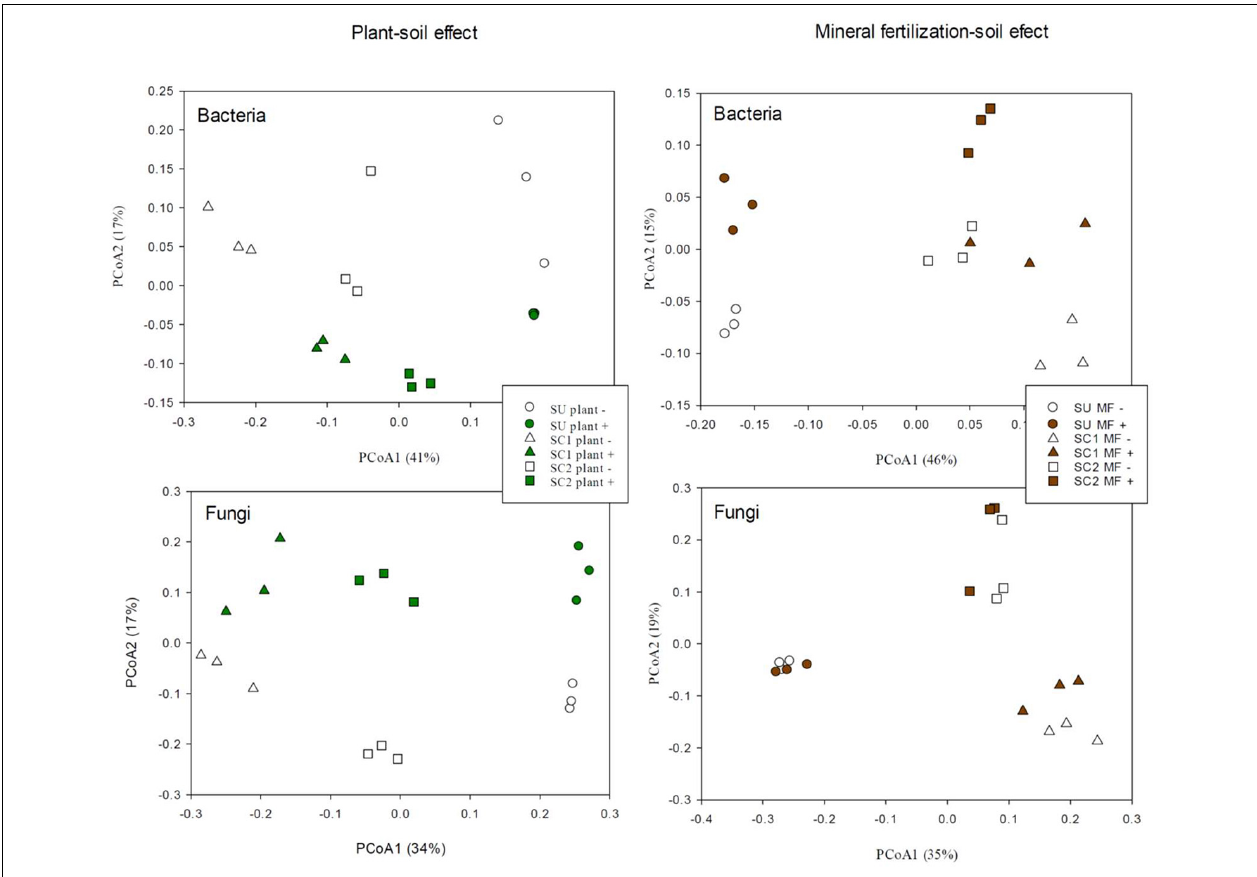
FIGURE 2 | Principal coordinate analysis (PCoA) of bacterial and fungal operational taxonomic units (OTUs) in the three different used soils (S, SC1, SC2) combined with the effects of the presence of plant and the effects of used soils (S, SC1, SC2) combined with mineral fertilization in the presence of plants.